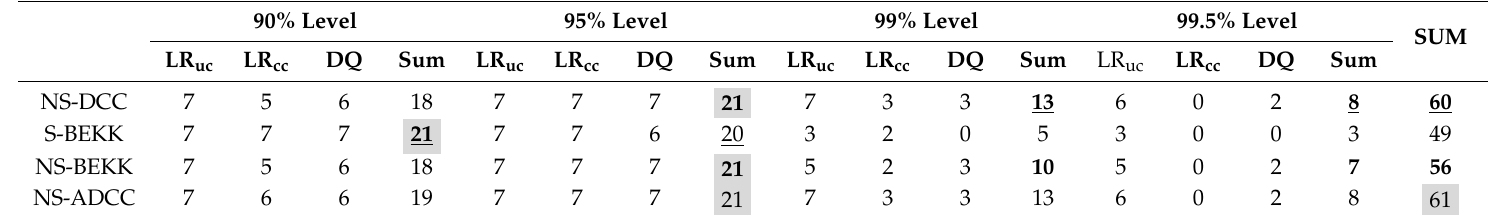
Panel C. w 1 =75%, and w 2 =25% bi-component portfolios